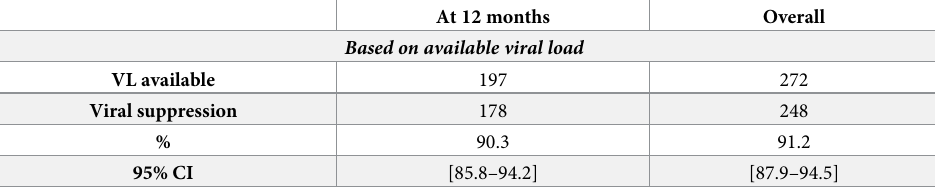
Table 3. Viral load suppression at 12 months and